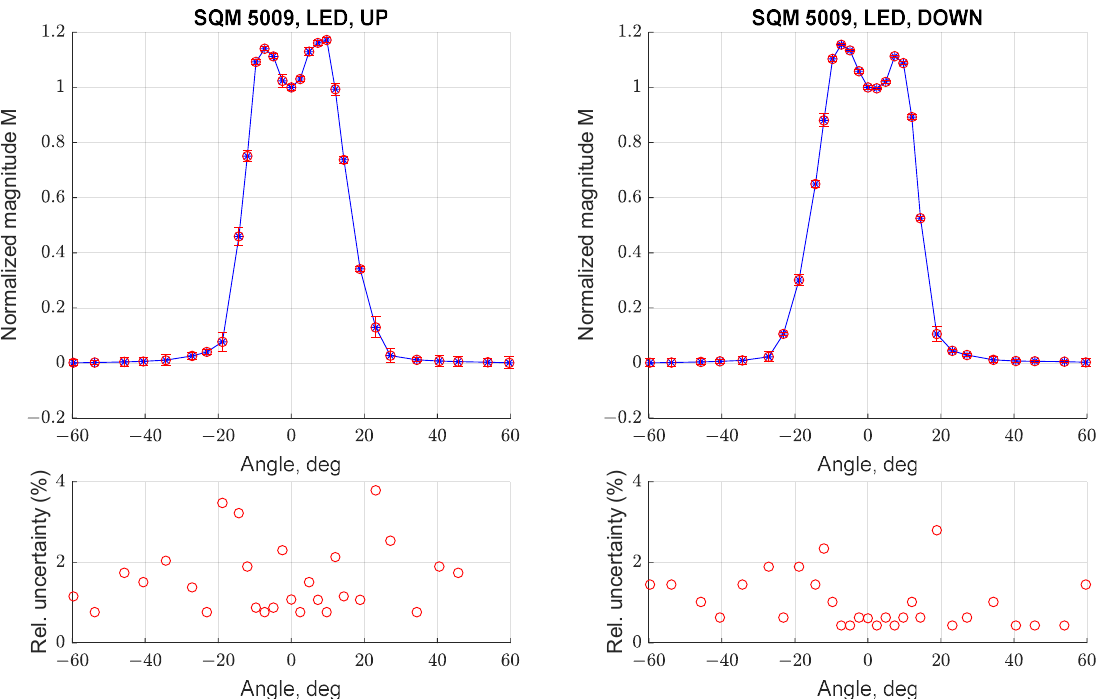
Figure 8. Normalized angular response curve ( top ) and relative uncertainty (1 σ , bottom ) for three scans performed with SQM-LE 5009 (UP and DOWN configuration).